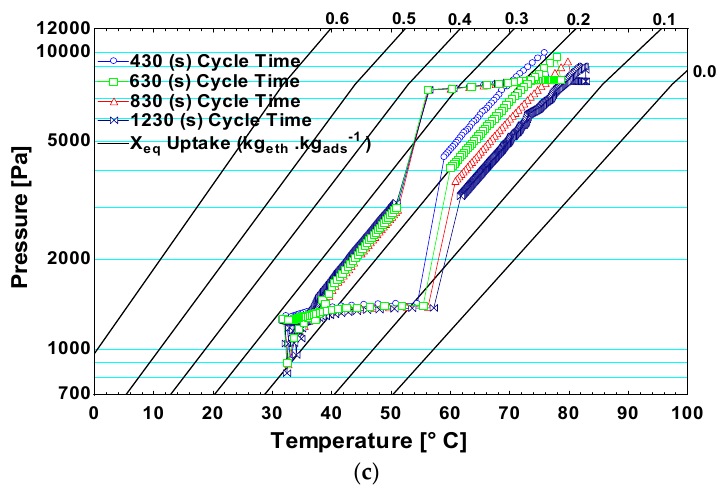
Figure 8 . P-T-Xeq diagram for the carbon-based composite adsorbent bed in a complete cycle under different cycle times and composite thicknesses of ( a ) 2 mm, ( b ) 5 mm, and ( c ) 10 mm. The Performance of the Ice Production System The net impacts of the changing of the cycle times on the SDIP and COP of the ice production system at composite thicknesses of 2, 5, and 10 mm are shown in Figure 9.